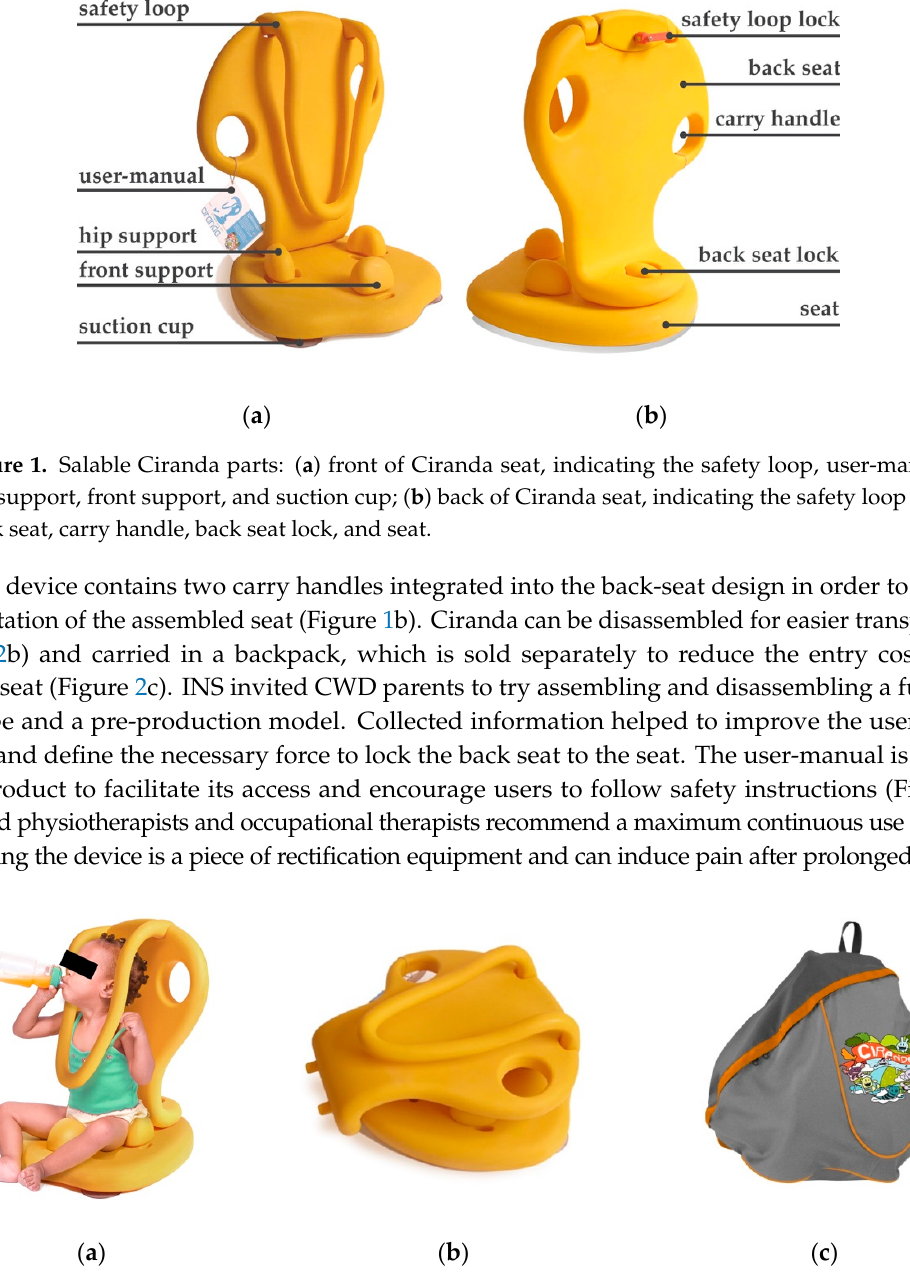
Figure 2. Salable Ciranda: ( a ) Ciranda seat with a child sitting and drinking a bottle independently; ( b ) Ciranda seat with the backrest disassembled and placed over the seat with parts assembled; ( c ) Ciranda seat backpack.